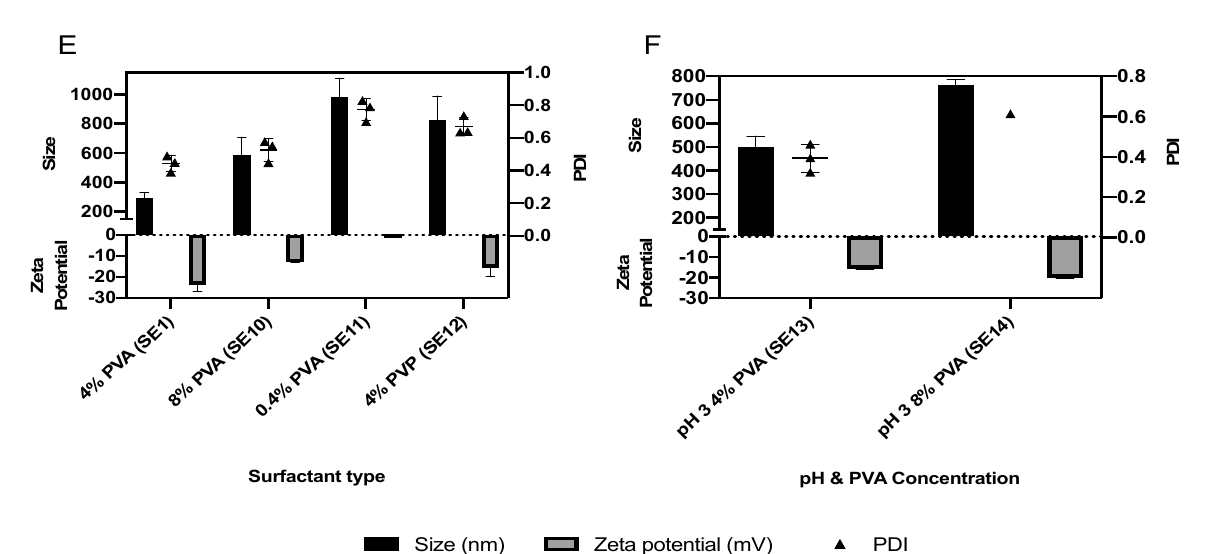
Figure 2. The impact of sonication time ( A ), polymer amount ( B ), drug amount ( C ), sonication amplitude ( D ), surfactant type ( E ), pH and PVA concentration ( F ) on the average particle size, PDI and zeta potential of the nanoparticles manufactured using the single emulsion technique.